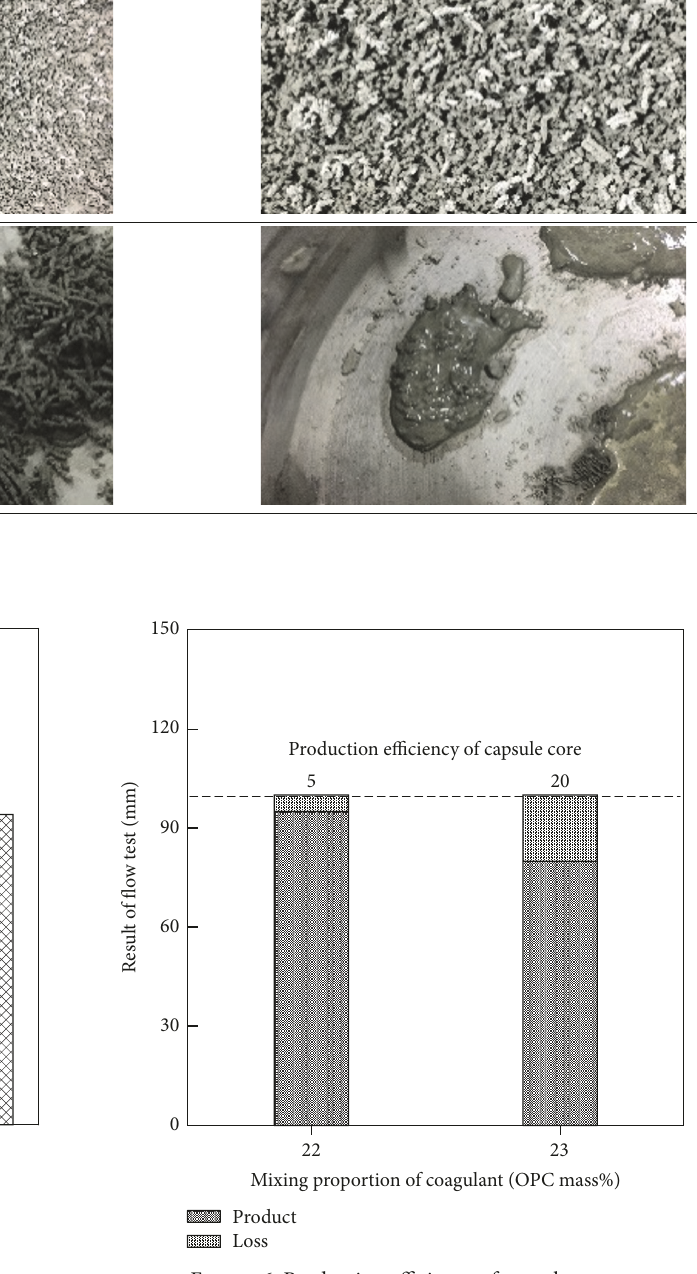
Figure 6: Production efficiency of capsule